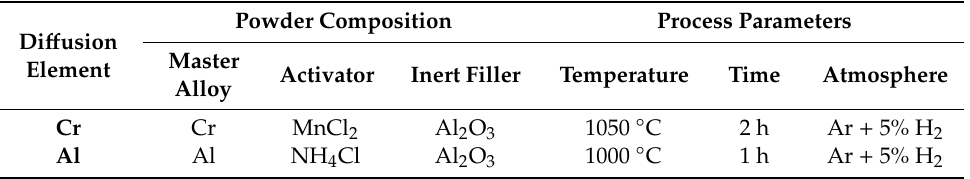
Table 2. Overview of the manufacturing parameters for Cr- and Al-coatings as well as the Cr / Al-coating for which both single-step processes were carried out